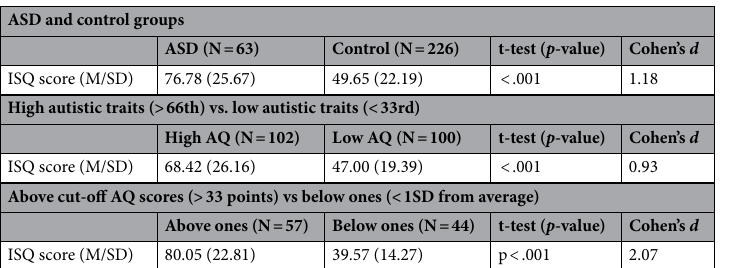
ASD and control groups ASD (N = 63) Control (N = 226) High autistic traits (> 66th) vs. low autistic traits (< 33rd)